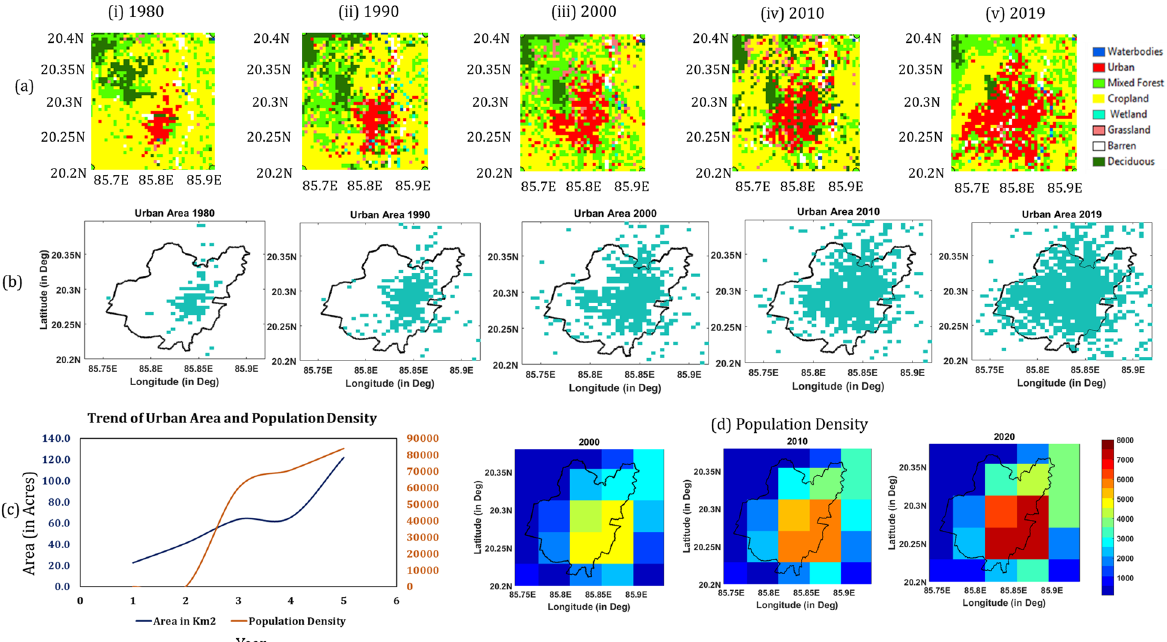
Fig. 8 a Classified LULC map for the study area, b spatial distribution of urban built-up area over the study area for 1980, 1990, 2000, 2010, and 2019 year, c Decadal variation of urban area (km 2 ) and population density across Bhubaneswar, and d Spatial distribution of population density